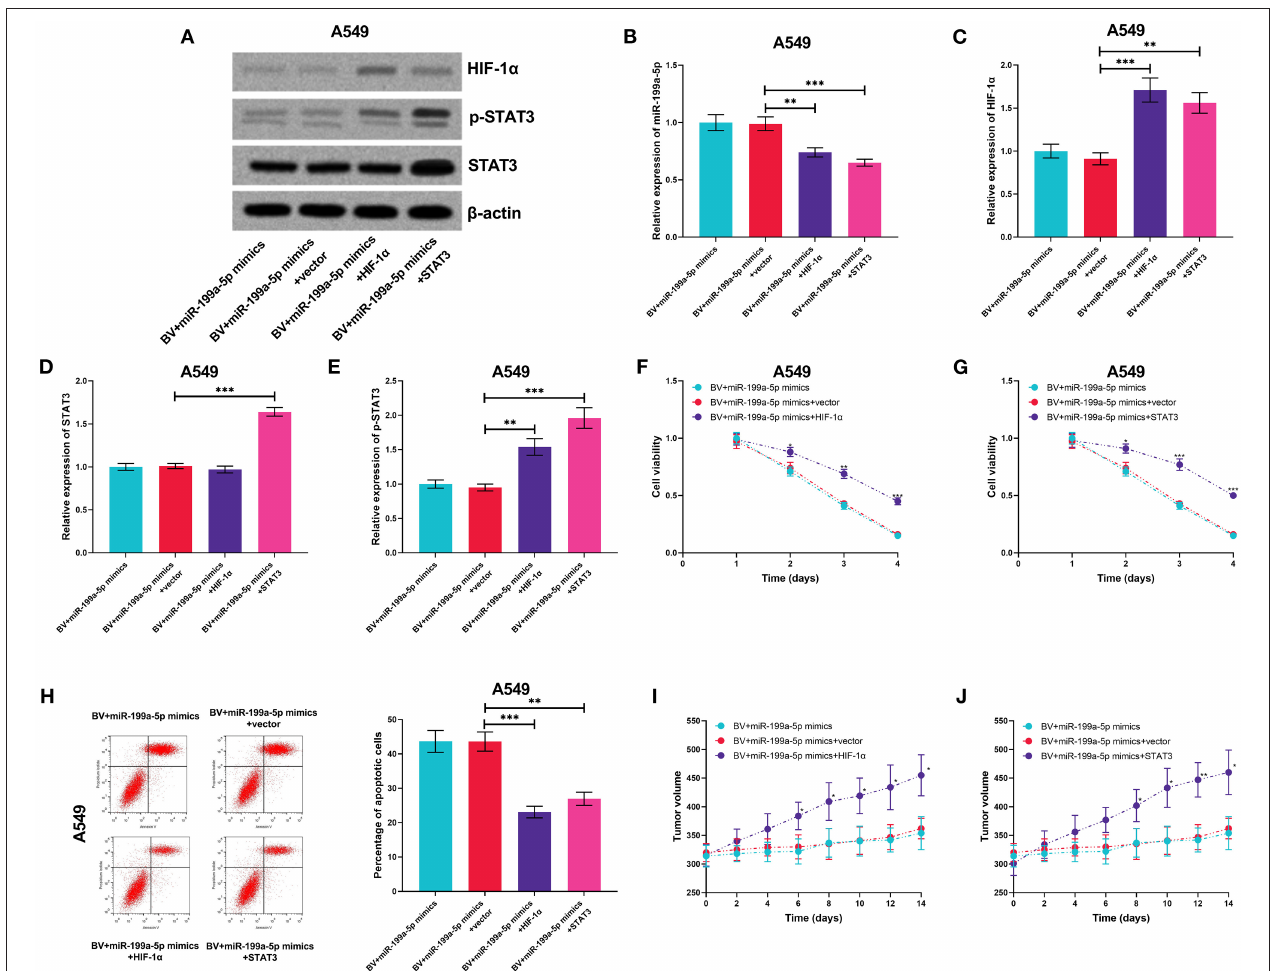
FIGURE 9 | HIF-1 α and STAT3 reversed the effects of miR-199a-5p on enhancing the sensitivity of A549 cells to bevacizumab. After A549 cells were transfected with miR-199a-5p mimics, or co-transfected with miR-199a-5p mimics and HIF-1 α overexpression plasmids (or STAT3 overexpression plasmids), the cells were treated with bevacizumab (BV). (A–D) Western blotting was used to detect the expressions of HIF-1 α , STAT3, and p-STAT3 in A549 cells. (E) qRT-PCR was used to detect miR-199a-5p expression in A549 cells after the transfection and BV treatment. (F,G) Proliferation of A549 cells was examined by the CCK-8 assay. (H) Apoptosis of A549 cells was measured using flow cytometry. (I,J) After A549 cells were transfected, the cells were planted into the mice, and then the mice were treated with BV. The changes of tumor volume with time in each group were recorded. All of the experiments were performed in triplicate. * p < 0.05, ** p < 0.01, and *** p < 0.001,